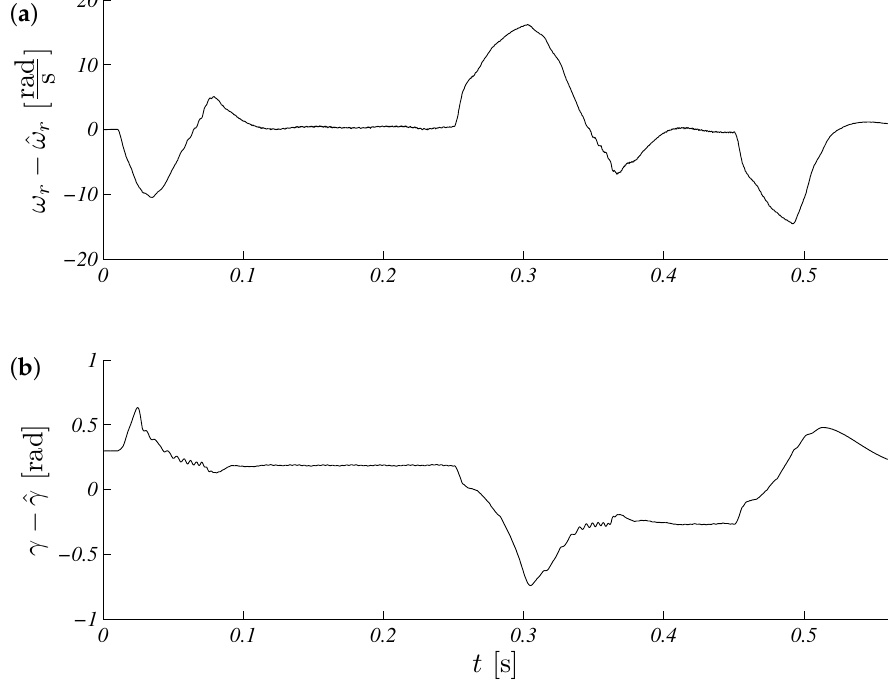
Figure 6. Unscented Kalman filter estimation speed ( a ) and torque ( b ) errors for referenced speed ω ∗ r = 104.72 rad s